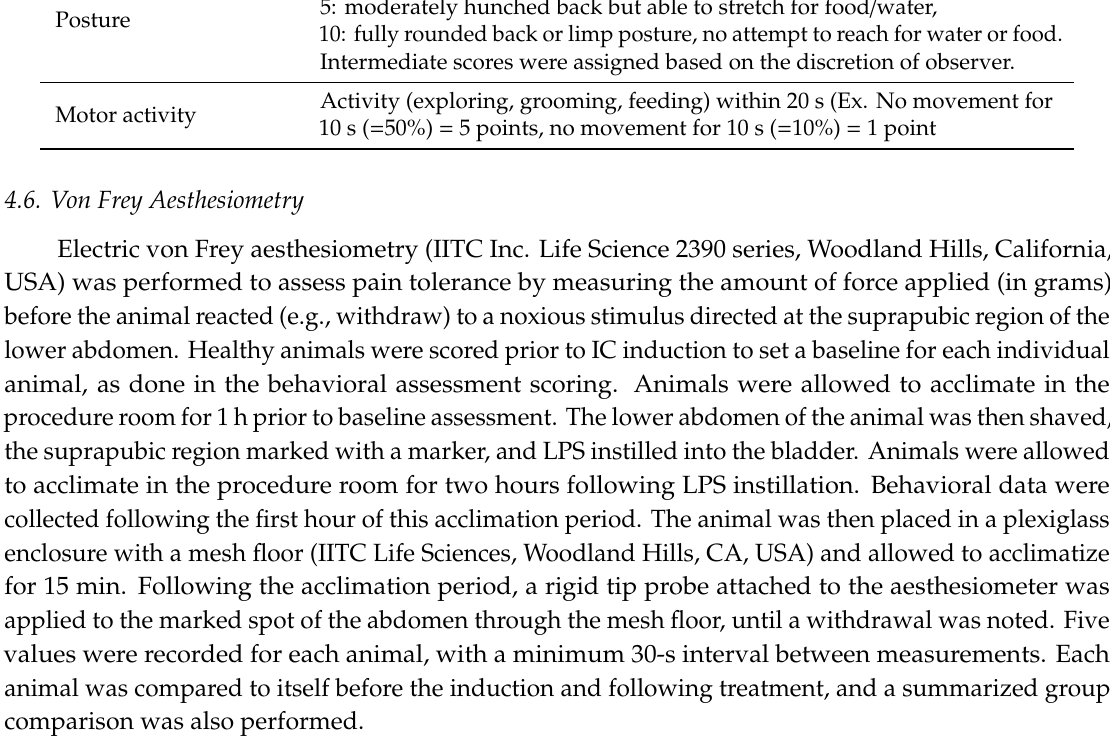
Supplementary Materials: The following are available online. Figure S1: Leukocyte adhesion in submucosal bladder venules of female wild-type and CB 2 R knockout (KO) BALB / c mice for the following experimental groups: wildtype control (CON, n = 5), LPS-induced IC in wildtype animals (LPS, n = 5), CB 2 R KO control (KO-CON, n = 5), LPS-induced IC in CB 2 R KO (KO-LPS, n = 4). LPS groups received a 50 µ L intravesical instillation of 150 µ g / mL LPS, which was replaced by 50 µ L of saline after 30 min. Control groups received 50 µ L saline intravesically, replaced by another 50 µ L saline instillation after 30 min. IVM was performed at the end of the 2 h observation time. Data is presented as mean ± SD. * <